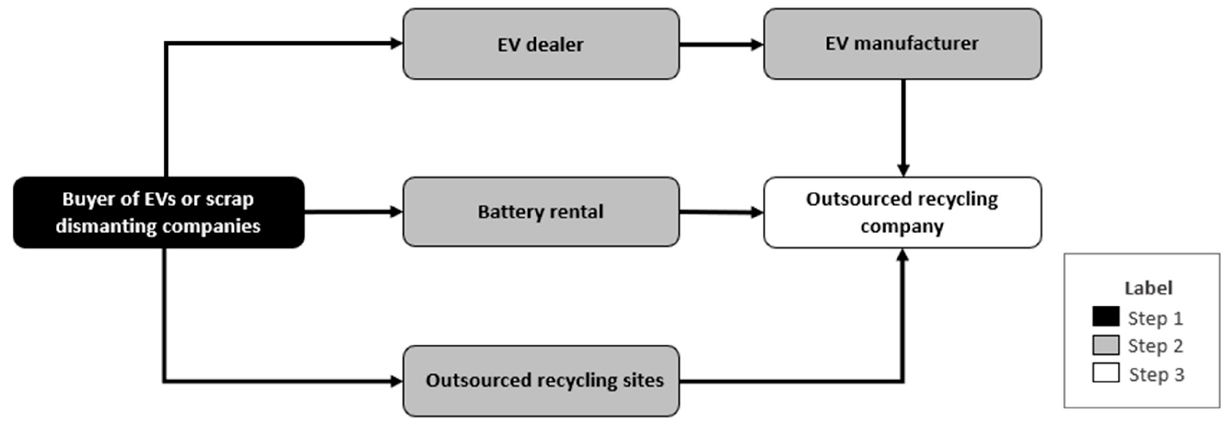
Figure 9. Proposed route for recycling lithium-ion batteries in Brazil. Adapted from [33].